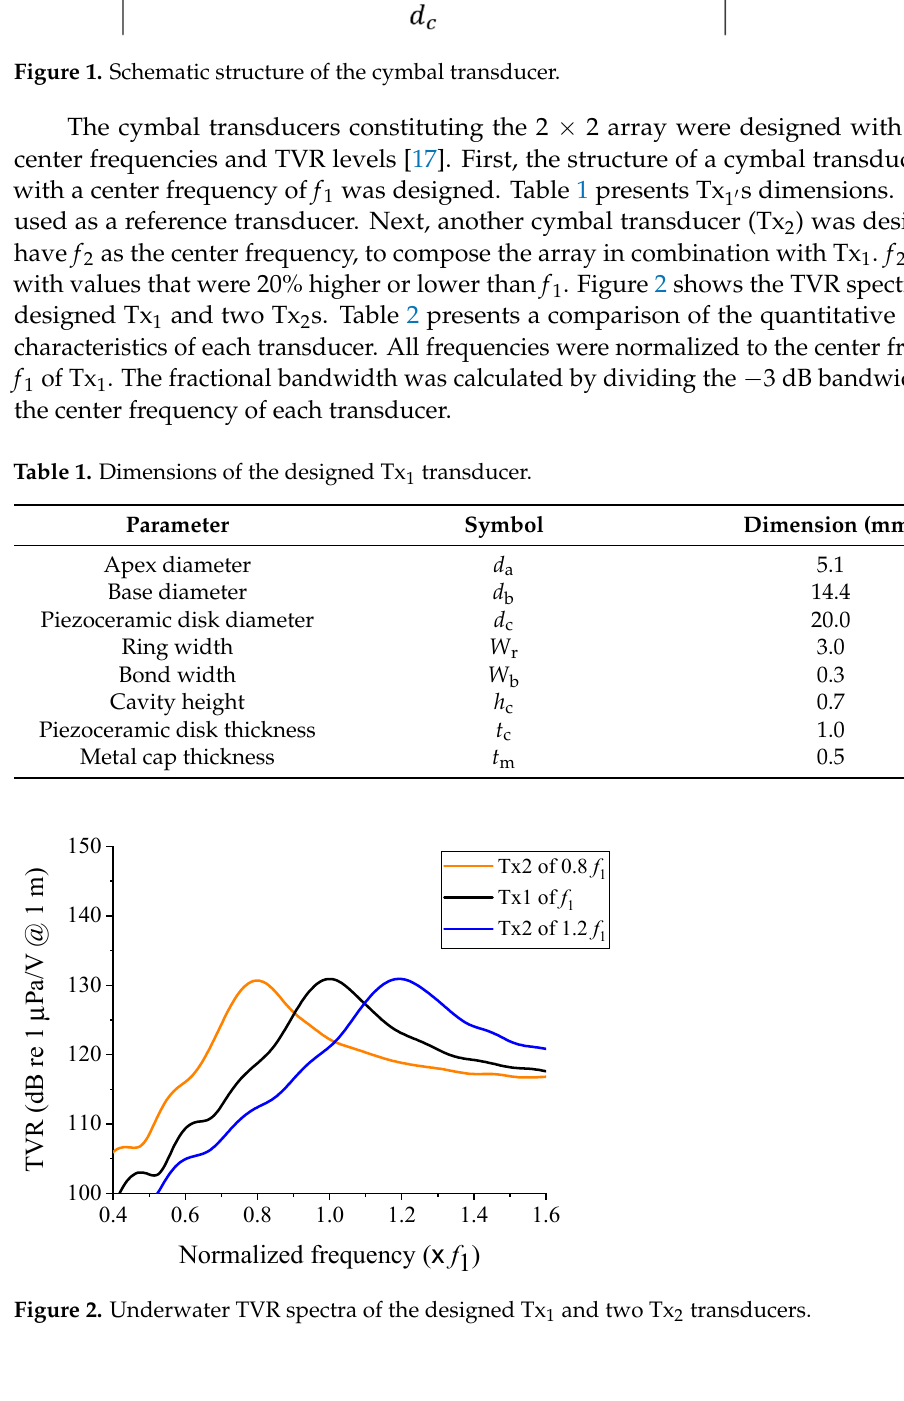
Figure 3. A 3D FEA model of the 2 × 2 cymbal array. With PZFlex ® , a three-dimensional FEA model of the array immersed in water was constructed to simulate the TVR. A sufficiently large amount of water was set outside the array to preserve the underwater transmission characteristics of the planar array. The ar- ray pattern had two orthogonal symmetric planes, so only a quarter model was analyzed to save calculation time. The element size in the FEA model was 0.15 mm. The whole model consisted of 127 million elements and 128 million nodes. Absorption boundary conditions were enforced onto the outer edges of the water domain such that sound re- flection would not occur at the edges. The sound pressure emitted from the array was calculated at a far-field point in the vertical direction from the upper cap. 3. Effect of the Structural Parameters on the 2 × 2 Cymbal Array Performance This study aimed to design an array pattern that can achieve the widest bandwidth. Accordingly, the influence of the structural parameters on the cymbal array performance was analyzed by using the FEM. The structural parameters considered herein were the dielectric polarity direction of the piezoceramic disks in Tx 1 and Tx 2 , the center frequency of Tx 2 relative to that of Tx 1 , and the spacing between the centers of Tx 1 and Tx 2 . We observed the effect of the dielectric polarity direction of a piezoceramic disk by analyzing cases where the PZT disks in Tx 1 and Tx 2 had the same polarity direction or